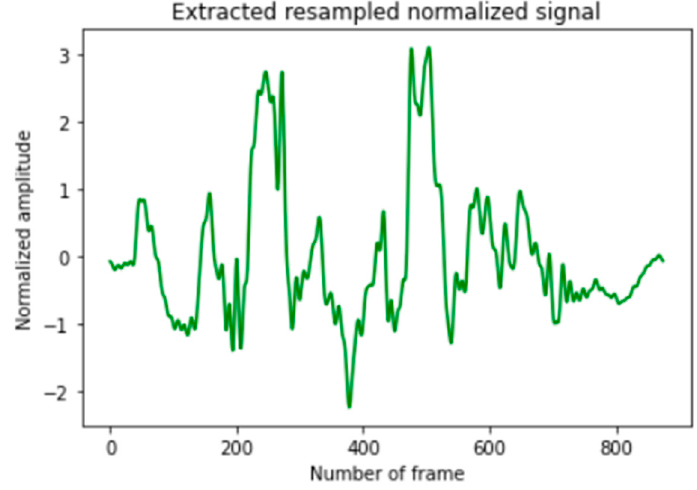
Figure 5. An example of extracted normalized signal from a random 7 s video using POS algorithm.